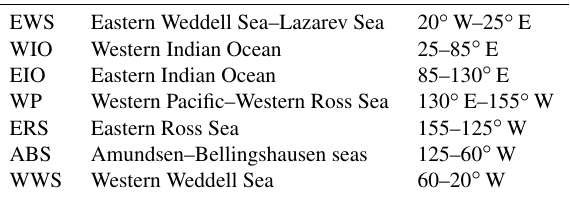
Table 1. Regions used for the regional analysis (Fig. 5).